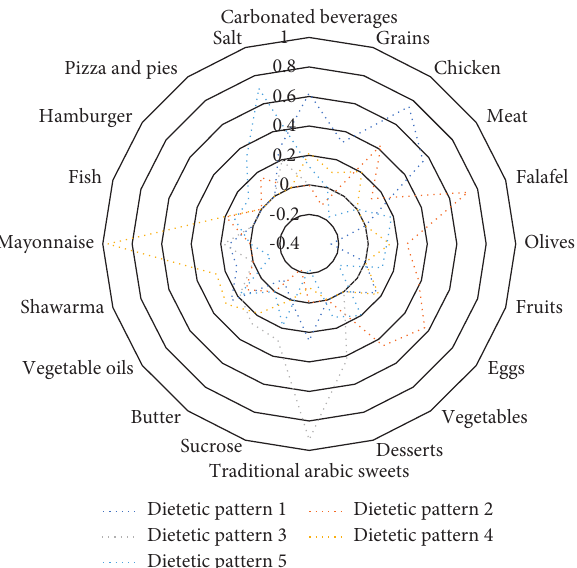
Figure 1: Radar graph of factor loadings for each dietary pattern. Dietetic pattern 1 is composed of foods with high caloric-protein intake and saturated fat. Dietary pattern 2 comprises foods of traditional consumption in the Syrian diet. Pattern 3 is composed of foods with a high contribution of simple carbohydrates and saturated fat. Pattern 4 is composed of foods of traditional con- sumption in the Syrian diet with a predominance of mono- and polyunsaturated fatty acids. Pattern 5 is formed by fast food with a high predominance of energy and